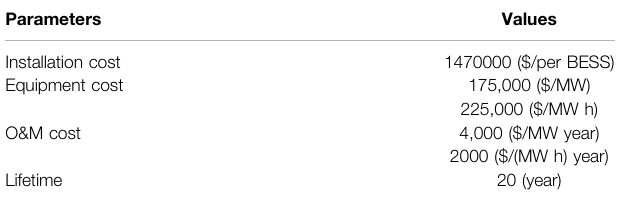
TABLE 1 | The economic parameters of BESSs. Parameters Values Installation